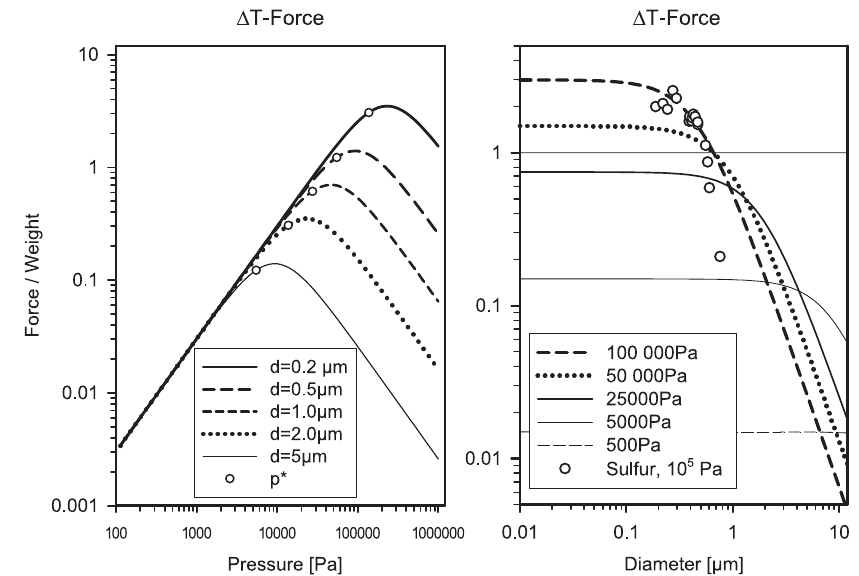
Fig. 6 Photophoretic Δ T force as a function of pressure for various particle diameters. The force is given relative to the weight of the particle. The data points in the right graph are for sulfur spheres (Parankiewicz,